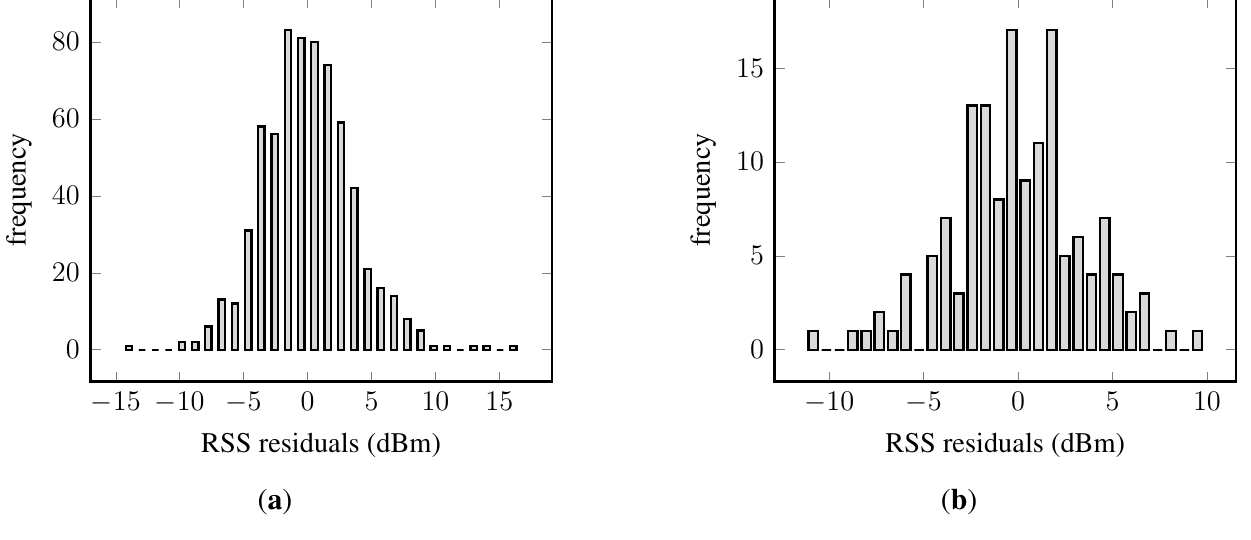
Figure 8. Histogram of residuals of two Gaussian process regression models, each for a different access point: ( a ) An access point with many fingerprints; ( b ) an access point with few